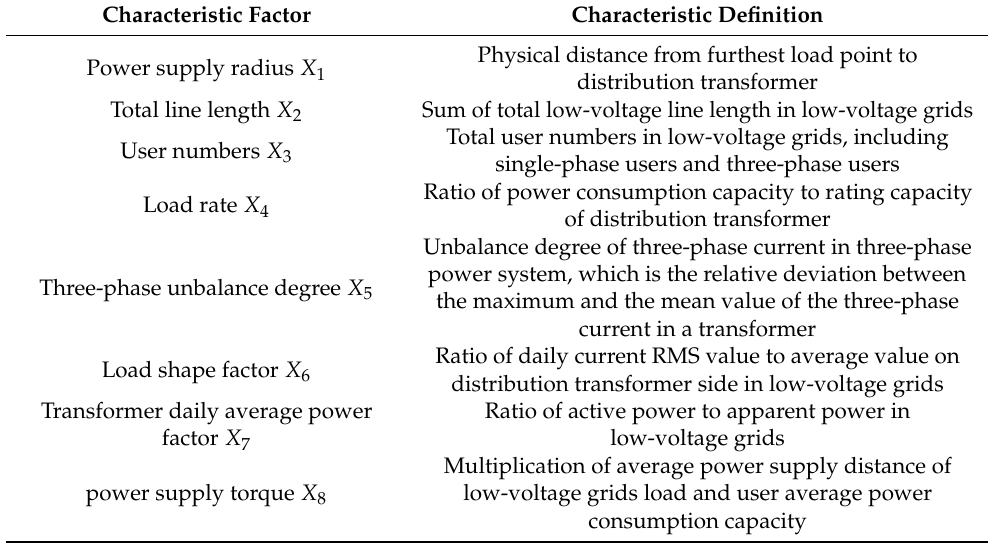
Table 2. Characteristic factors for theoretical line loss in low-voltage grids.